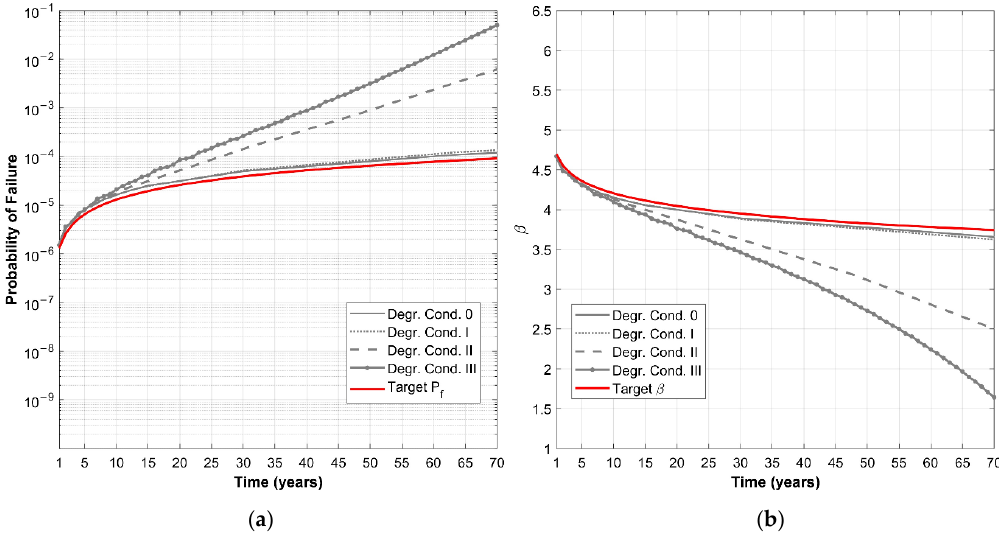
Figure 8. Time-dependent probability of failure ( a ) and reliability index 𝛽 ( b ) for residential buildings—reinforcing steel class 3 and concrete class 3 for different steel degradation conditions.